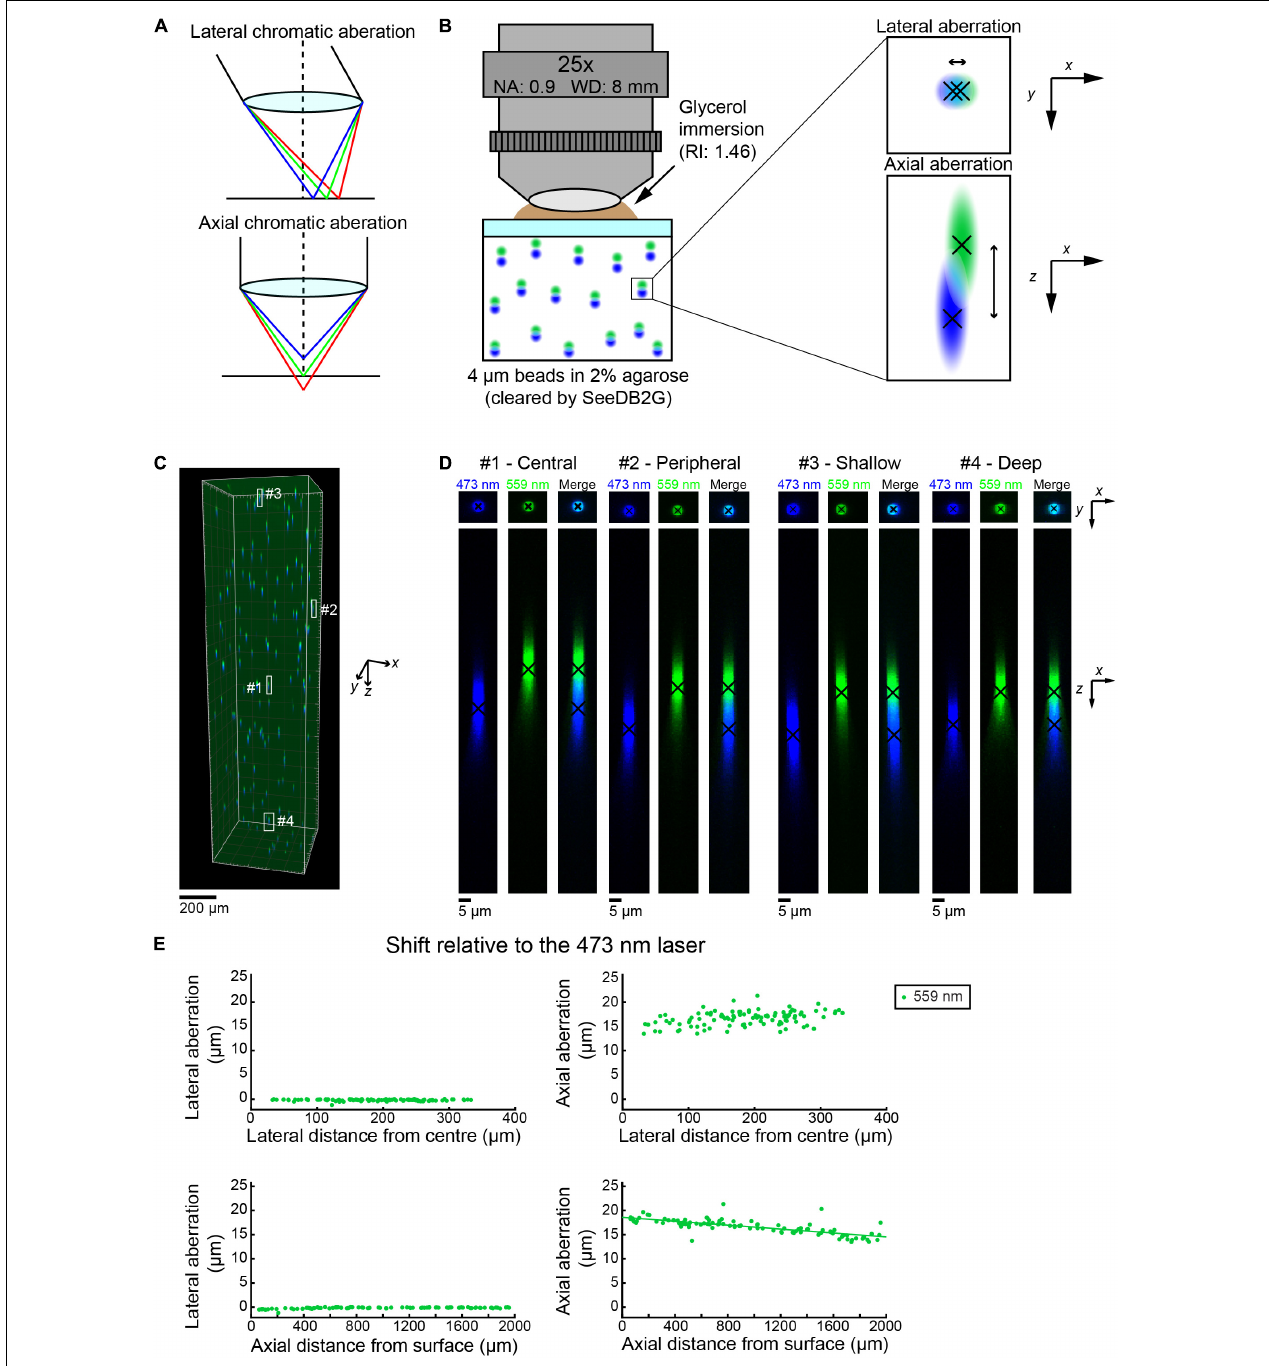
FIGURE 1 | Measuring chromatic aberrations with fluorescence beads in SeeDB2G (Olympus 25 × ). (A) Lateral and axial chromatic aberrations can occur in confocal microscopy. (B) Measurement of chromatic aberrations with a 25 × custom-made objective lens (Olympus). Fluorescent beads (4 µ m) were embedded in agarose gel and then cleared with SeeDB2G (RI, 1.46). The agarose sample was mounted with a 0.17 mm thick coverslip. Glycerol (RI, 1.46) was used for immersion. (C) A volumetric confocal image of the fluorescent beads in the gel (volume rendering). (D) High-magnification images of representative beads [ x–y and x–z maximum intensity projections (MIPs)]. Centroid positions for each channel are shown by black crosses. (E) Lateral and axial chromatic aberrations at 559 nm were determined as shifts relative to the 473 nm laser. Positive axial aberration values indicate that the bead is higher than it appears in the 473 nm image. Axial aberrations were more pronounced. Moreover, the axial aberrations were depth-dependent and could be fit with a regression line (green line).